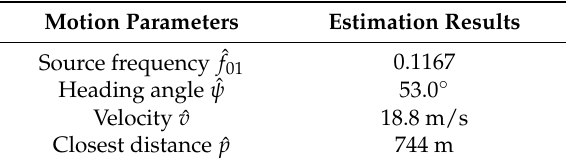
Figure 19. The estimation results of the horizontal distance before and after compensation. The parameter estimation results of the target in the horizontal direction are listed in Table 3. Table 3. The parameter estimation results in the horizontal direction.